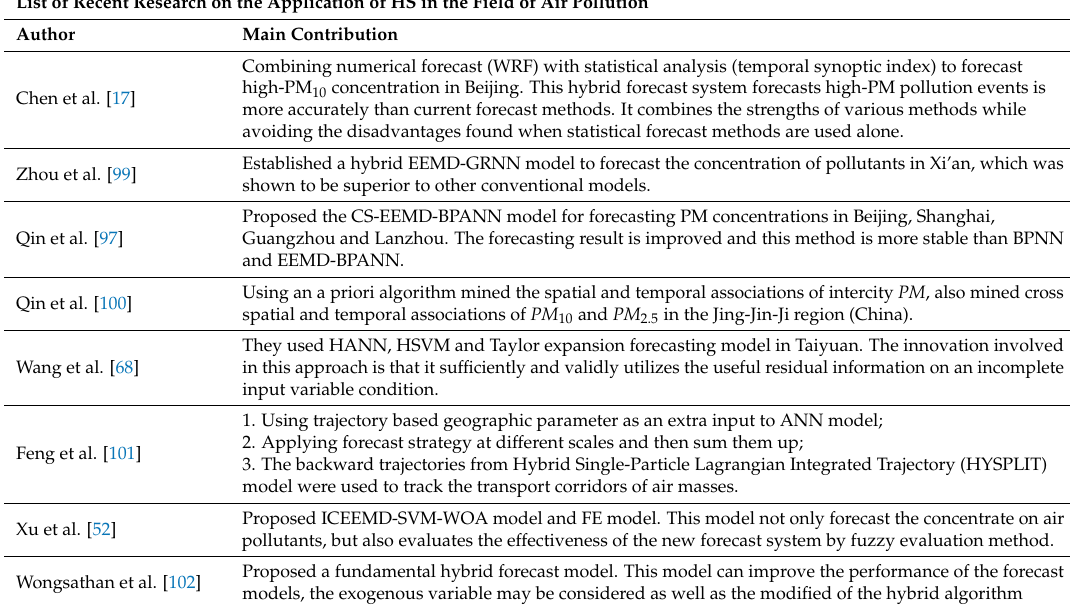
Table 21. The short summary of hybrid system for air